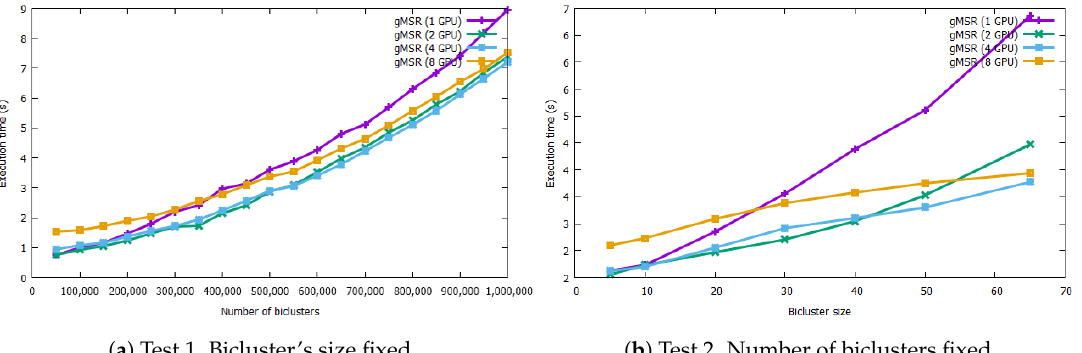
Figure 5. This figure includes two graphs that measure the execution rates in seconds for the single-GPU and multi-GPU modes when processing synthetic bicluster datasets. The graph on the left shows the result when the number of biclusters increases while their size is fixed. The graph on the right shows the execution times when the size of the biclusters increases. In both cases, the multi-GPU version presents an optimal